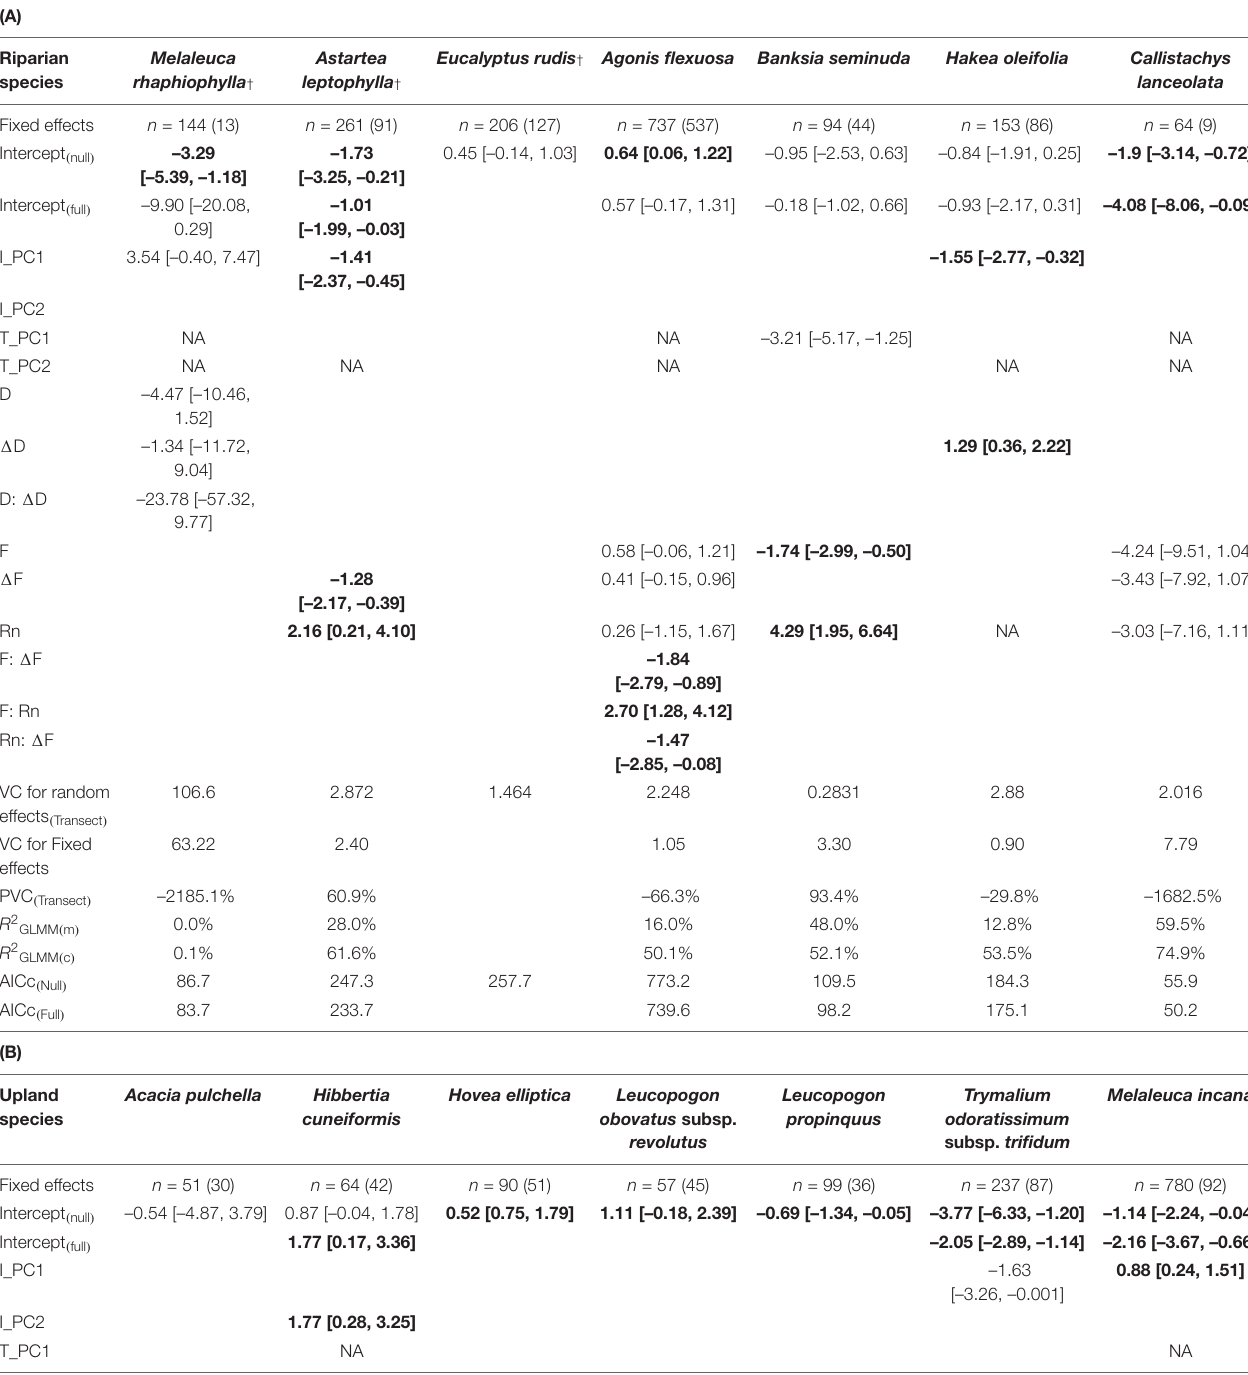
TABLE 2 | Generalized linear mixed effects models testing the relative frequency of immature to mature individuals of (A) riparian and (B) upland species along the riparian zones of the Warren River as a function of mean annual rainfall (Rn), and either inundation duration (D) and change in duration ( (cid:49) D) or flood frequency (F) and change in flood frequency ( (cid:49) F). Variation in forest structure is described at transect and individual level as the covariates, T_PC1 and T_PC2, and I_PC1 and I_PC2, respectively. The proportional change in variance (PCV) for the random effect (transect identity) is calculated between the null and final models. The Akaike Information Criterion (AICc) is a relative measure of goodness of fit scaled to the number of parameters in the model. R 2 GLMM ( m ) is the marginal variance explained by all fixed factors and R 2 GLMM ( c ) is the conditional variance explained by both fixed and random factors (Nakagawa and Schielzeth, 2013). NA indicates a term was not tested due to collinearities within the fixed predictor set. In species where the model fit was not better than the null model, results are shown for the null model only. Model coefficients highlighted in bold indicate significant predictors. Note, some models failed to converge due to insufficient variation within the tested environmental variables or age classes, and are therefore not presented for Melaleuca cuticularis , M. viminea , and Taxandria juniperina . † denotes an obligate riparian species. A complete list of tested models is provided in Supplementary Material 2